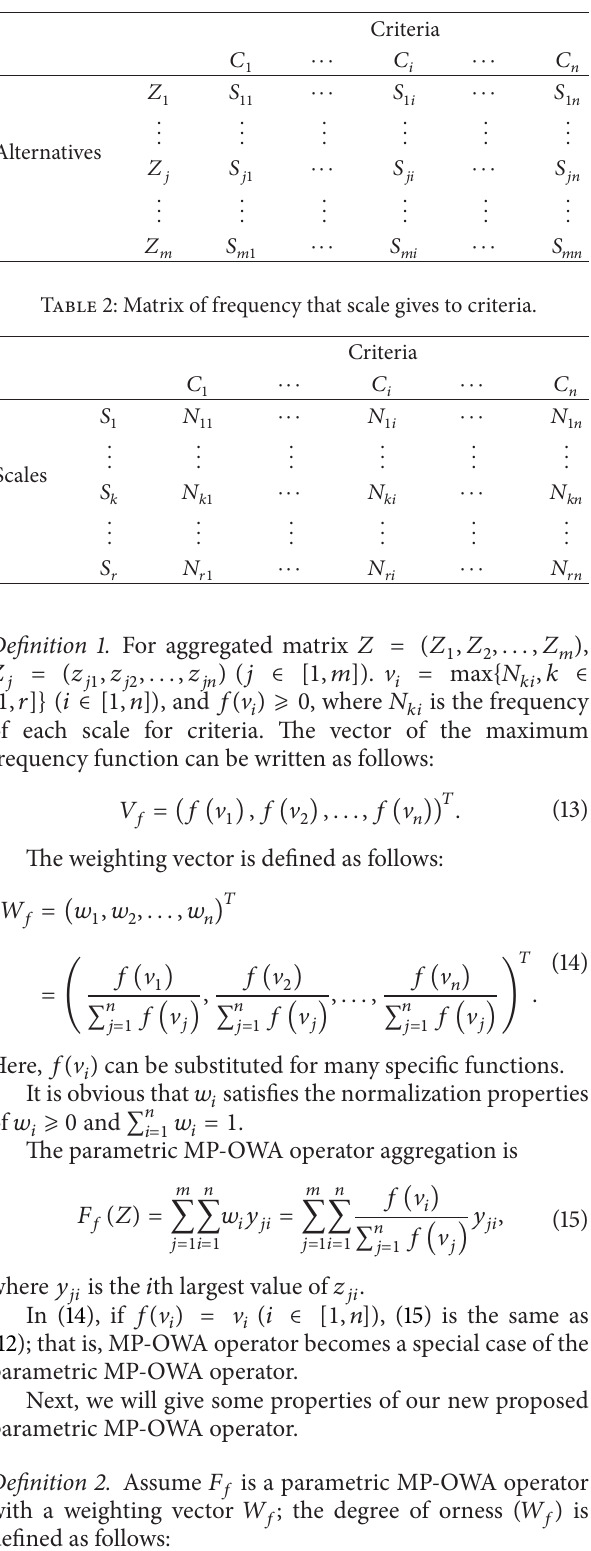
Table 1: Matrix of preference rating of 𝑛 criteria with 𝑚 alternatives.